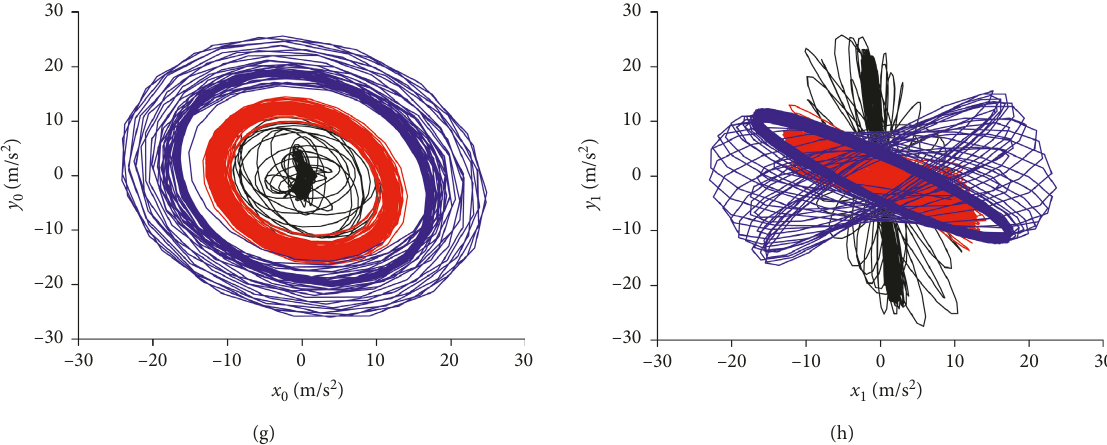
Figure 10: Comparing vibration synchronization and control synchronization. (a) The velocities of two motors. (b) The phase difference. (c) Amplitude of the mass center in y -direction. (d) Amplitude of the mass center in x -direction. (e) Amplitude of the edge position in y - direction. (f) Amplitude of the edge position in x -direction. (g) Mass center trajectory. (h) Edge position